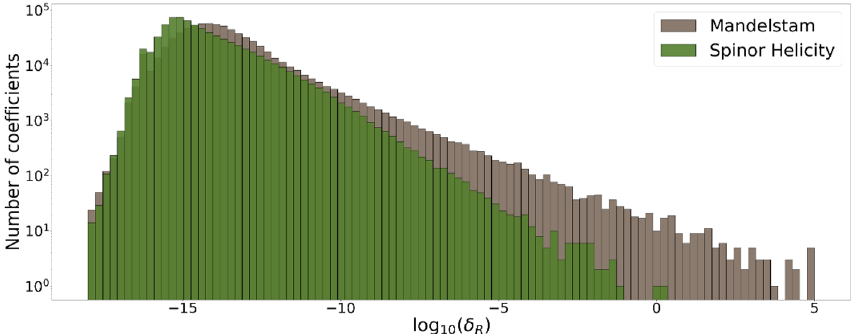
Figure 4 . Relative errors over a thousand phase-space points in a collider configuration of double- precision evaluations of spinor and Mandelstam